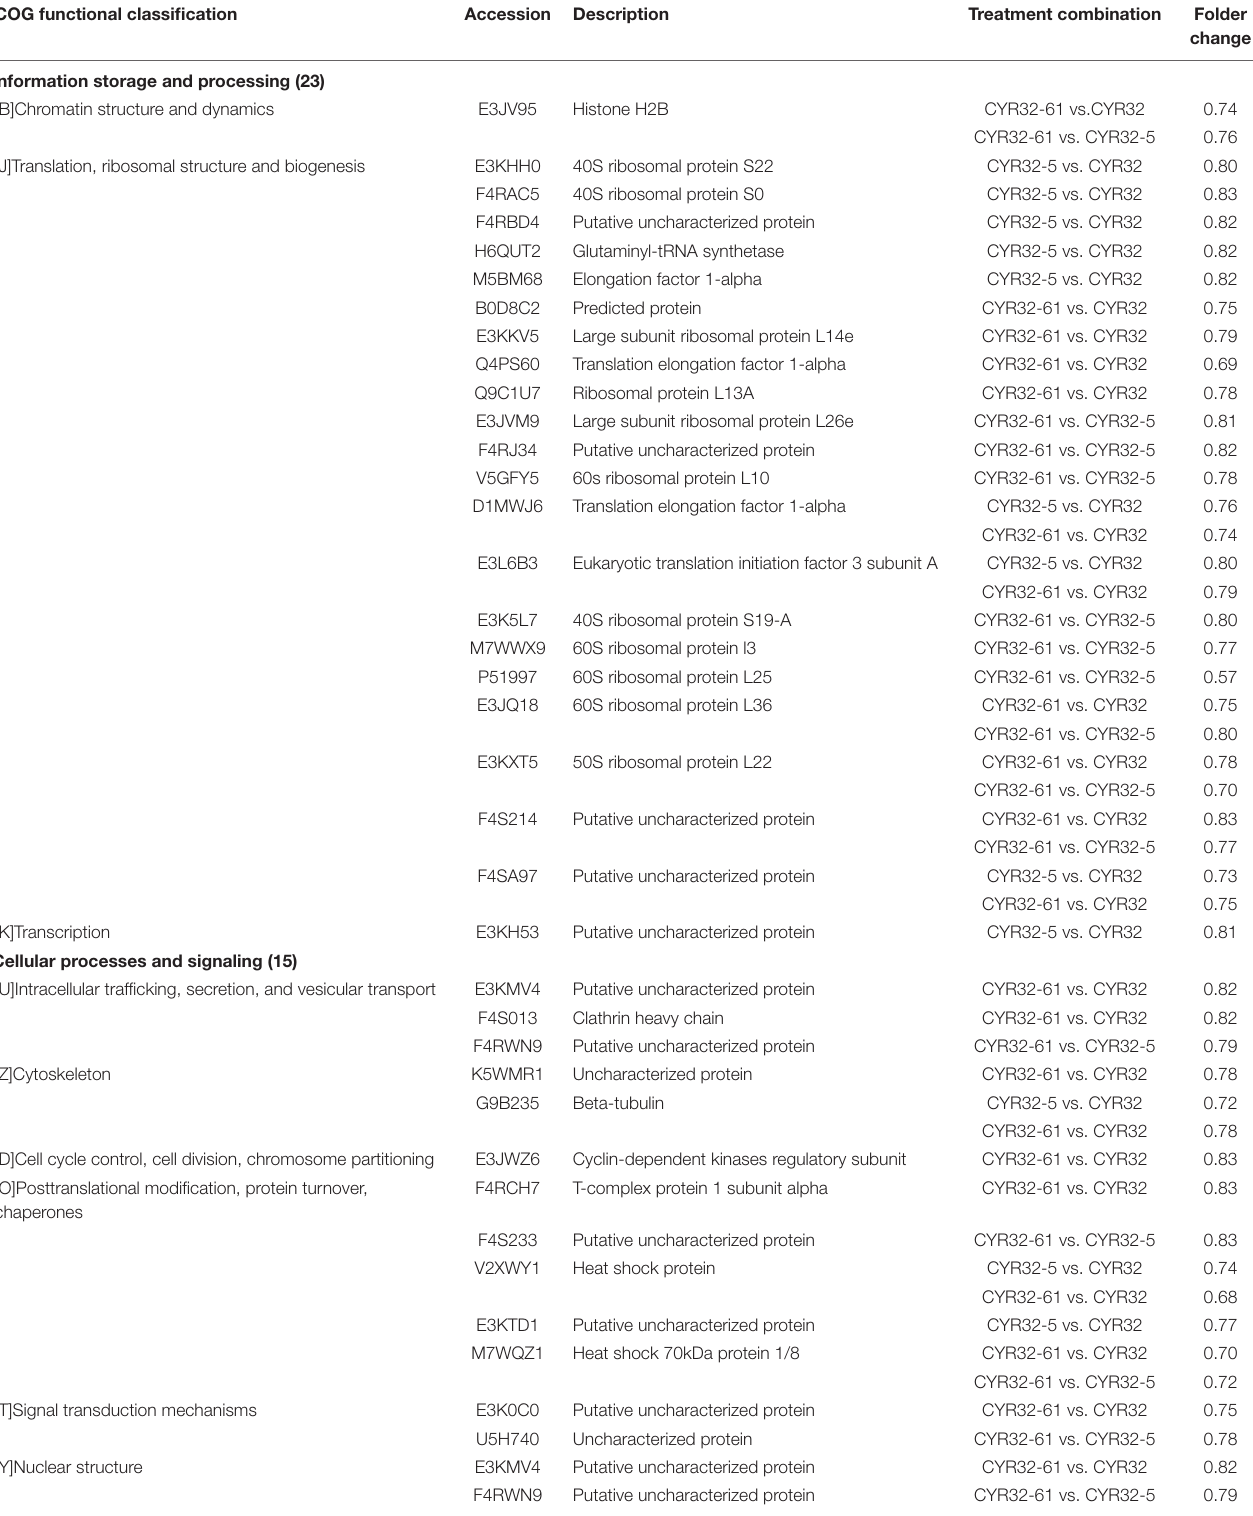
TABLE 3 | Functional annotations of the down-regulated differentially expressed proteins acquired in the combinations CYR32-5 vs. CYR32, CYR32-61 vs. CYR32, and CYR32-61 vs.